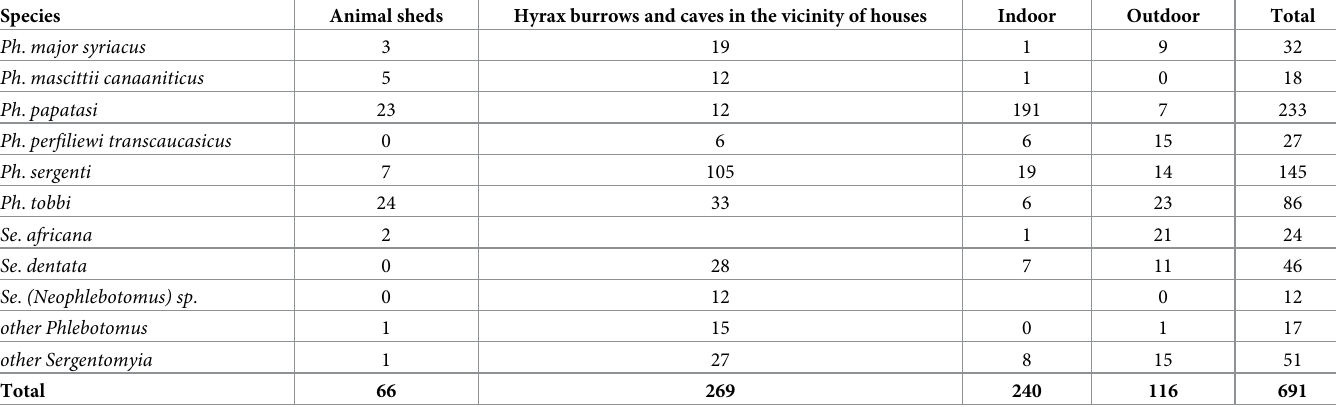
Table 2. Sand flies collected inside, outside animal sheds and the rock crevasses inhabited by hyraxes in the vicinity of houses. Species